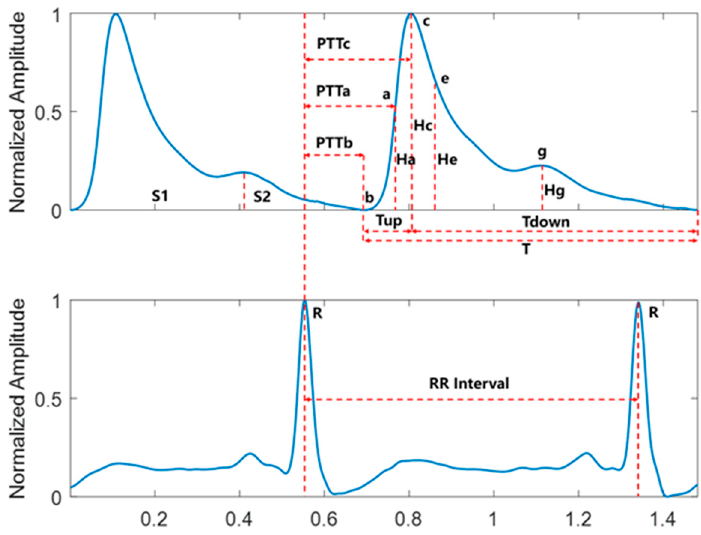
Figure 2. Schematic diagram of features.